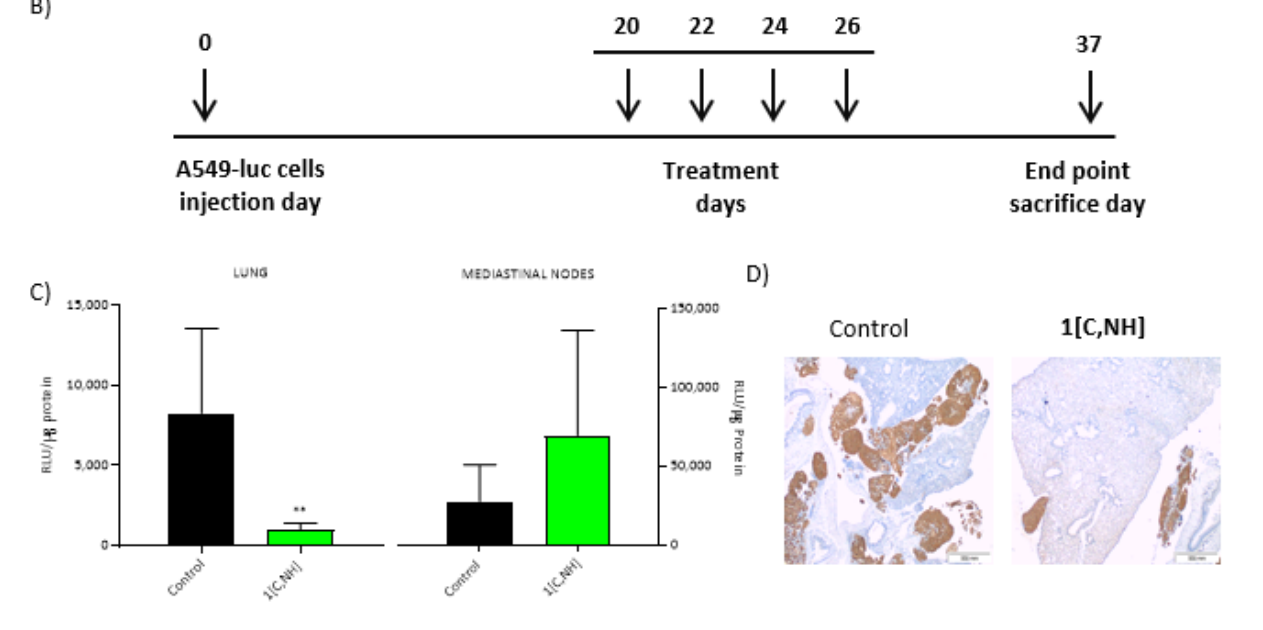
Figure 8. ( A ) Iridium biodistribution in extracted organs 4 h after i.v. injection of 1[C,NH] . ( B ) In vivo monitoring scheme. ( C ) Luciferase activity quantification measured in protein extracts of lung or mediastinal nodes. ( D ) Immunohistochemical staining of mouse lungs using anti-CK7 antibody. Left: control group. Right: Treated group. Brown stain shows tumor cells.